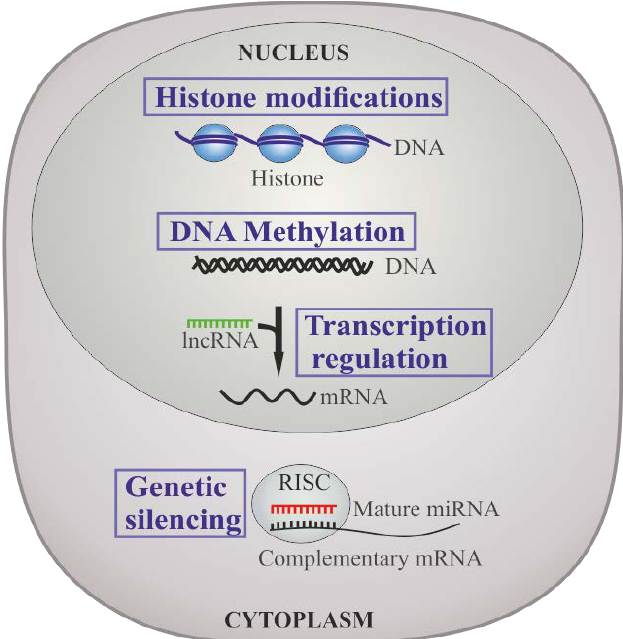
Figure 3. Epigenetic regulation in CML. Histone modification is pivotal in gene regulation. Generally, DNA methylation exerts a negative modulation of gene transcription through DNA methyltransferases (DNMTs) and methyl-cytosine dioxygenases at cytosine residues in CpG dinucleotides. Non-coding RNAs play crucial roles in regulating gene expression, either via miRNA-induced silencing complex (miRISCs), targeting mRNA for degradation; or lncRNAs which are involved in regulation of gene transcription, epigenetic modifications, and posttranscriptional processing.